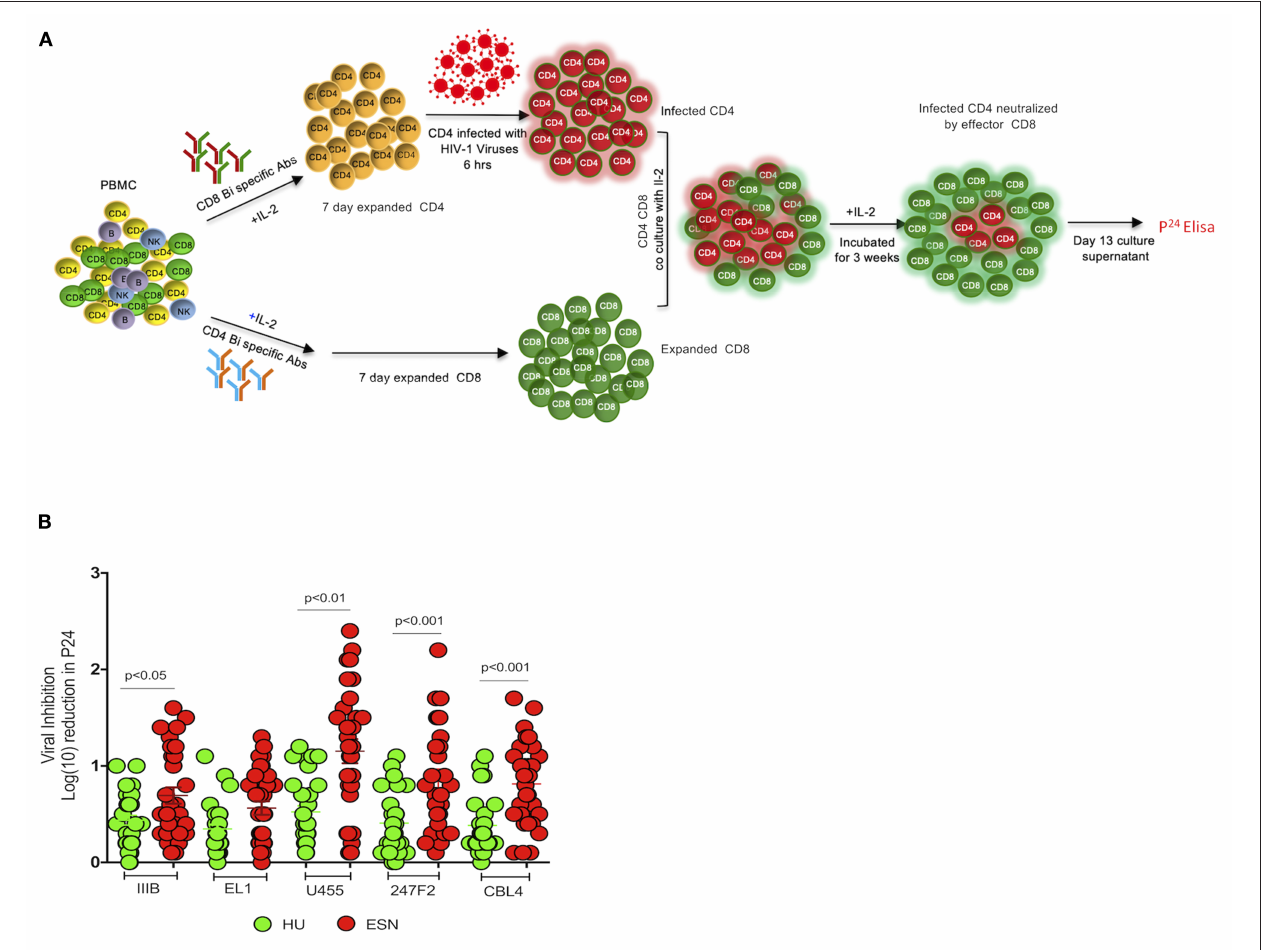
FIGURE 4 | CD8 + T cell-mediated inhibition of diverse clades of HIV-1 using viral inhibition assay: (A) Schematic diagram of viral inhibition assay. PBMCs were resuspended in Roswell Park Memorial Institute (RPMI) medium with 10% heat-inactivated fetal calf serum to generate CD4 + target and CD8 + effector T cells; 50U of IL-2 and 0.5 µ g/mL of CD3/CD4 or CD3/CD8 + bispecific antibodies (Human Immunology laboratory, London) were added, respectively. Culture volumes were doubled at days 3 and 6 by the addition of fresh RPMI medium and IL-2. After 7 days, CD4T cells were infected with exogenous HIV-1 at a multiplicity of infection (MOI) of 0.01 for 4h. Following this, expanded CD8 + T cells were added to the wells of a tissue culture plate containing CD4 + T cells infected with each clade of HIV at a 1:1 ratio and incubated for 15 days. Half of the culture supernatant was replaced with medium containing IL-2 on days 3, 6, 8, and 10. Supernatant p24 content was measured on day 13 by enzyme-linked immunosorbent assay (ELISA) (PerkinElmer). CD8 + T cell-mediated inhibition was calculated as the log 10 reduction in p24 content of day 13 CD8 + and CD4 + T cell co-culture supernatants compared to that of CD4 + T cells alone. (B) Viral inhibition activity in terms of log 10 reduction in p24 levels in HESN and HU groups; Five HIV-1 subtypes were tested: 247FV2 (clade C), CBL4 (clade D), ELI-1 (clade A/D), IIIB (clade B), and U455 (clade A). Graphical representation of the viral inhibition activity in terms of log 10 reduction in the HESN and HU groups. The box and whiskers plots represent median, 25th, and 75th percentile and range (IQR). P- values were determined using Mann-Whitney’s T- test. (HESN, HIV exposed seronegative; HU, HIV unexposed seronegative